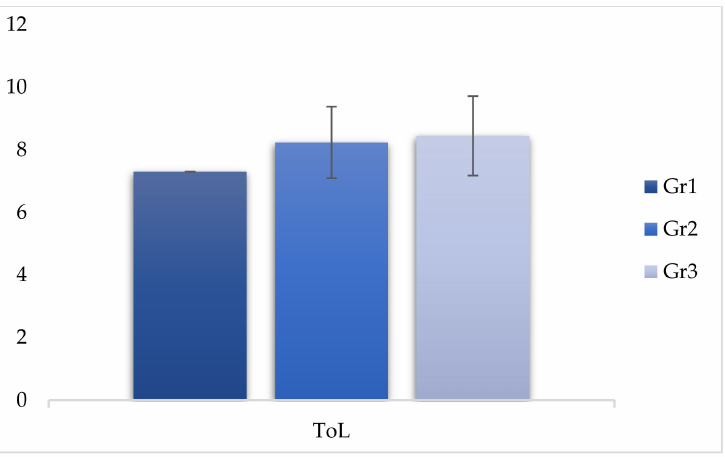
Figure 2. Comparison of ToL (Tower of London) between the three